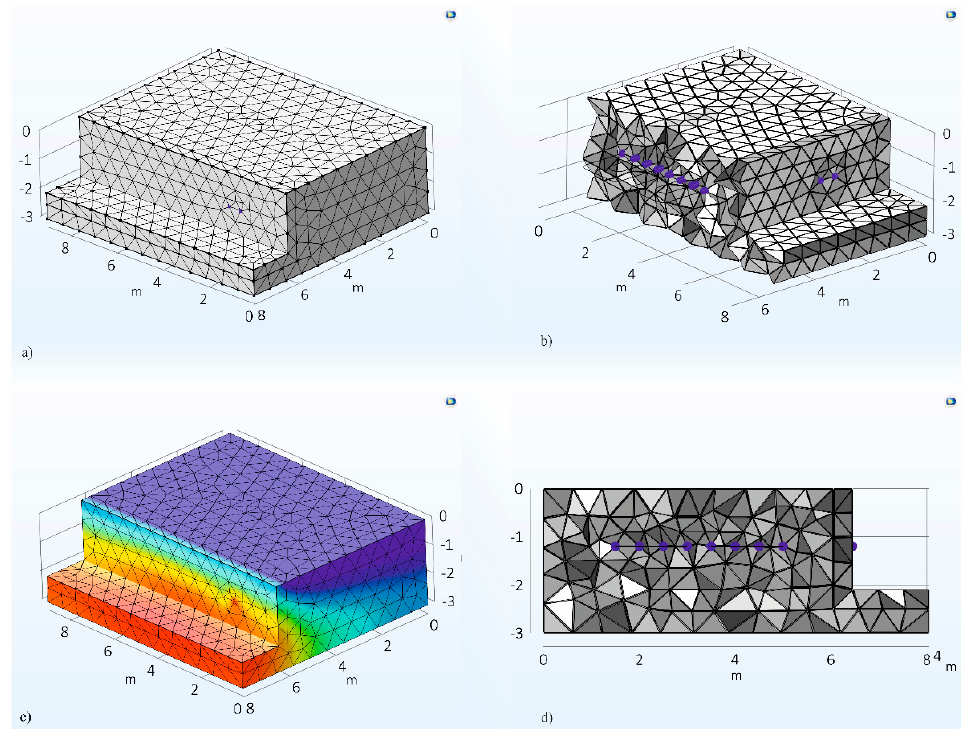
Figure 2. The tri-dimensional computational grid for the HGHE used for numerical simulation: ( a ) 3D computational grid exterior surfaces; ( b ) 3D section computational grid with interior and pipes visible; ( c ) 3D computational grid with temperature distribution; ( d ) 2D section perpendicular to the basement wall with pipes visible.